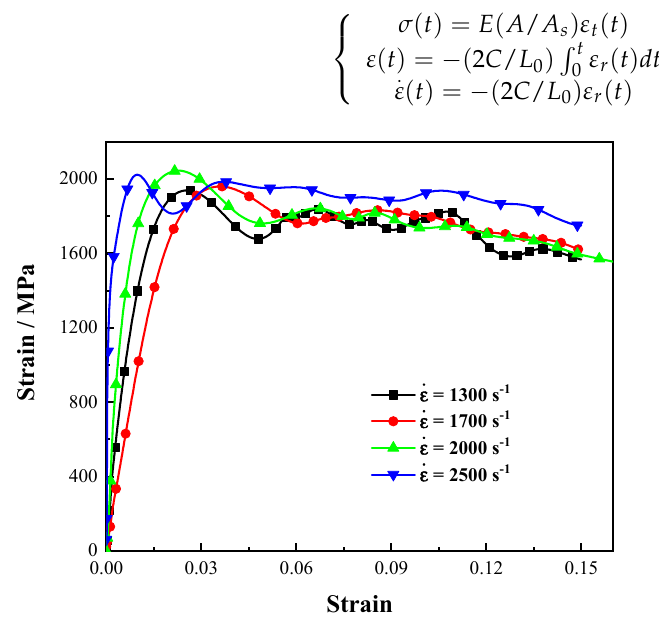
Figure 3. True stress–strain curves of SHTB tensile test at different strain rates.